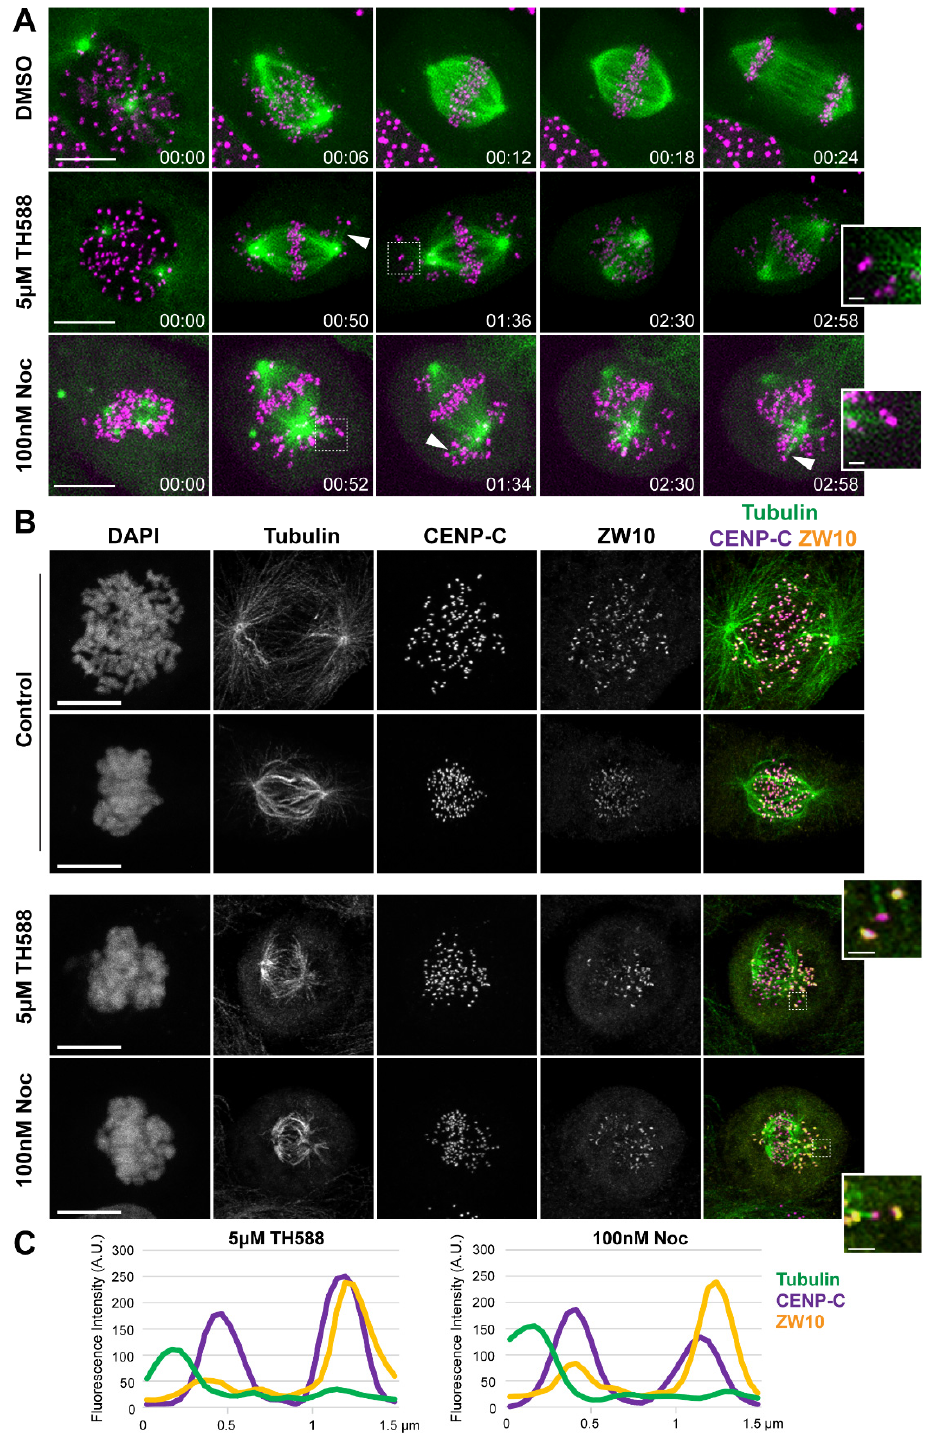
Figure 5. TH588 triggers mitotic arrest and erroneous cell divisions via premature stabilization of kinetochore-MT end-on attachments. ( A ) Representative spinning disk confocal time-series of mitosis in U2OS cells stably expressing CENP-A-GFP (magenta) and mCherry- α -tubulin (green) undergoing indicated treatments. Scale bar 10 µm. Time, hr:min. Arrowheads highlight stabilization of MTs attached to kinetochores. Dashed squares represent regions used for the zoomed insets highlighting syntelic attachments. Inset scale bar 1 µm. ( B ) Representative scanning confocal maximum intensity projections of U2OS cells undergoing indicated treatments, fixed and stained with antibodies against α -tubulin, CENP-C, ZW10, and DAPI to counterstain DNA. CENP-C is shown in magenta, α -tubulin in green and ZW10 in yellow in merged images. Scale bar: 10 µm. Zoomed insets highlight lack of ZW10 in kinetochores attached to MTs. Inset scale bar 1 µm. ( C ) Line profile scans